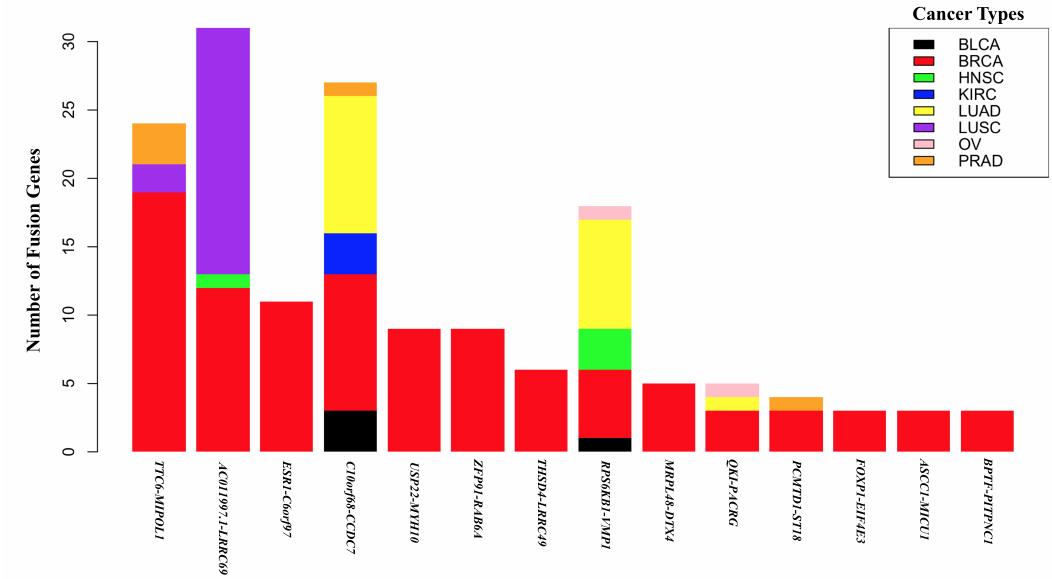
Figure 1. Occurrence of recurrent breast cancer transcript fusion genes across diverse cancer types. transcript fusion genes in 8 cancer types, BLCA (Bladder Urothelial Carcinoma), BRCA (breast Invasive Carcinoma), HNSC (Head and Neck Squamous Cell Carcinoma), KIRC (Kidney Renal Clear Cell Carcinoma), LUAD (Lung Adenocarcinoma), LUSC (Lung Squamous Cell Carcinoma), OV (Ovarian Serous Cystadenocarcinoma), and PRAD (Prostate